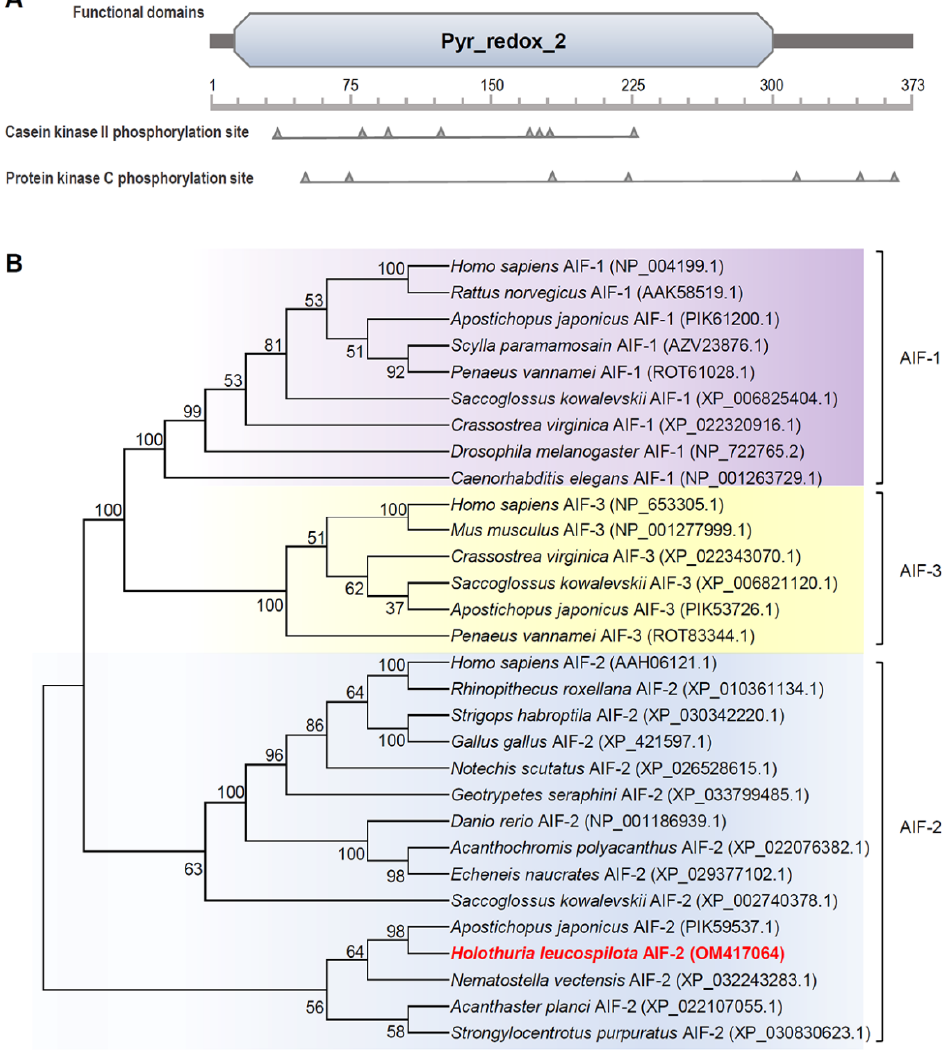
Figure 1. Functional domain and phylogenetic tree of Hl AIF-2. ( A ) Structural domain and active sites of Hl AIF-2 predicted using the SMART and ScanProsite programs. ( B ) Phylogenetic analysis of AIFs among various species using the neighbor-joining method with a bootstrap value of 1000.